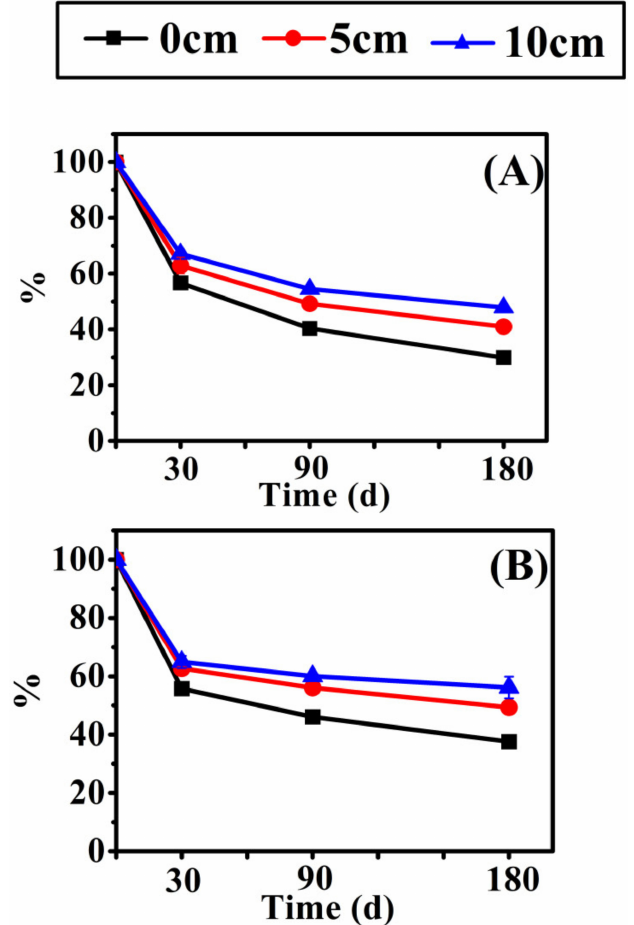
Figure 2. Percent mass remaining of Echinochloa crusgali ( A ) and Bidens tripartita ( B ) litter decomposi- tion after 30, 90, 180 days at 0, 5, 10 cm burial depths under flooding. Mass remaining is expressed relative to the initial litter mass. Error bars indicate ± 1 S.D.